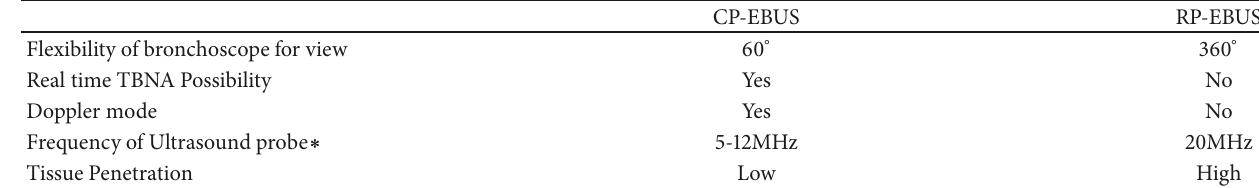
Table 1: Comparison of RP-EBUS and CP-CBUS.